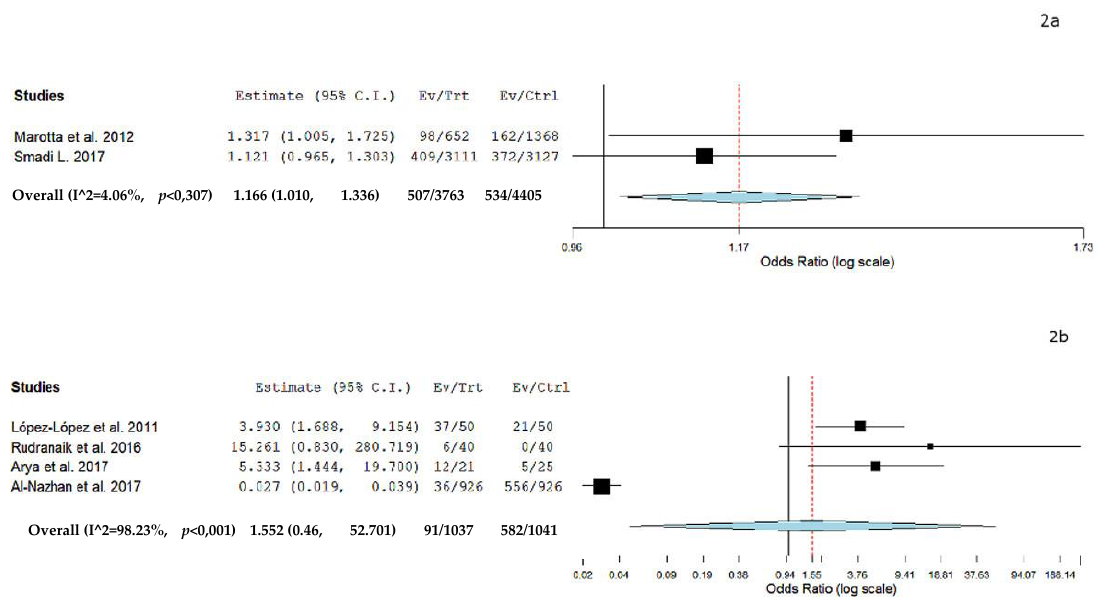
Figure 2. ( a ) Forest plot of prevalence of teeth with Diabetes Mellitus (DM) and Apical Periodontitis (AP); ( b ) Forest plot of prevalence of patients with DM and AP. Overall (I^2 = 98.23%, p < 0 . 001), 1.552 (0,46, 52.701), 91/1037, 582/1041.